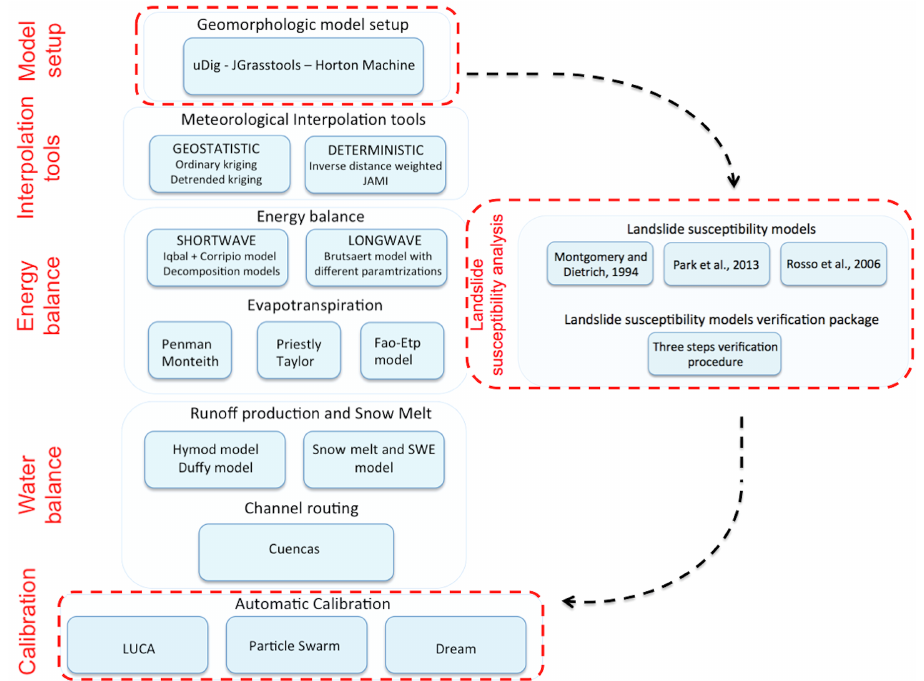
Figure 1. Integration of the landslide susceptibility analysis system in NewAge-JGrass hydrological